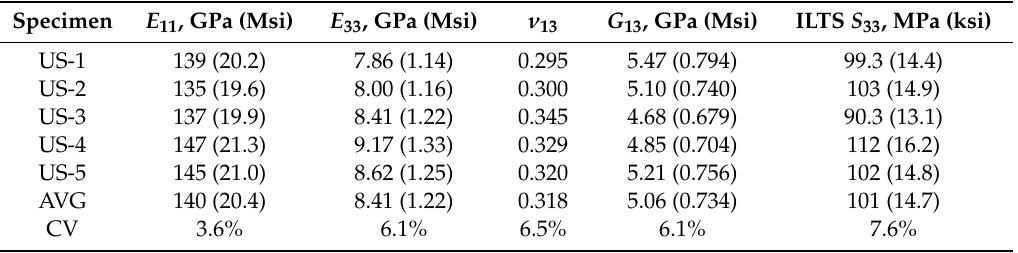
Table 1. Elastic constitutive properties and ILT strength for the carbon / epoxy unidirectional tape OHC-ILT specimens.